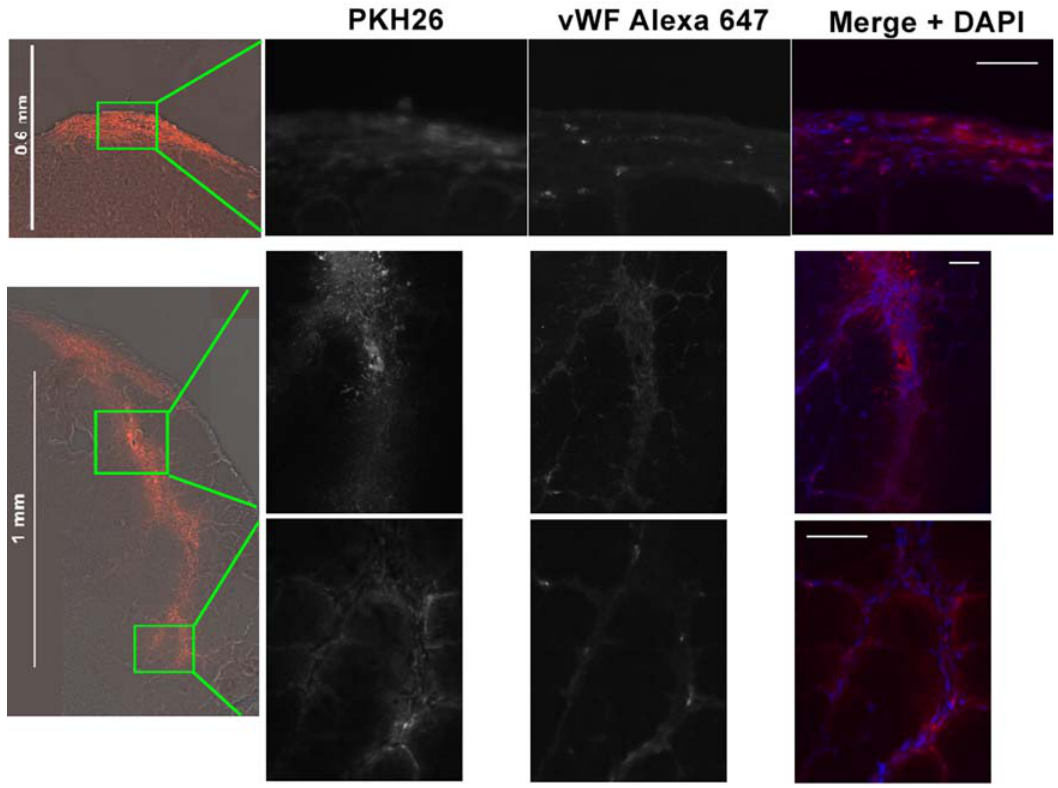
Figure 8. EC injected subcutaneously in matrigel migrate into the muscle. Top, a montage of the matrigel plug shows PKH26 + microvessels in the matrigel plug over the TA muscle. Bottom, A montage of an area approximately 80 m m distal shows migration of PKH26 + EC. EC invaded the TA from the matrigel plug and formed new microvessels along their migration path and also integrated into existing vessel. Staining with anti-vWF in Alexa 647 (magenta) highlights EC angiogenic capability within the matrigel plug and muscle. Scale bars=50 m m.